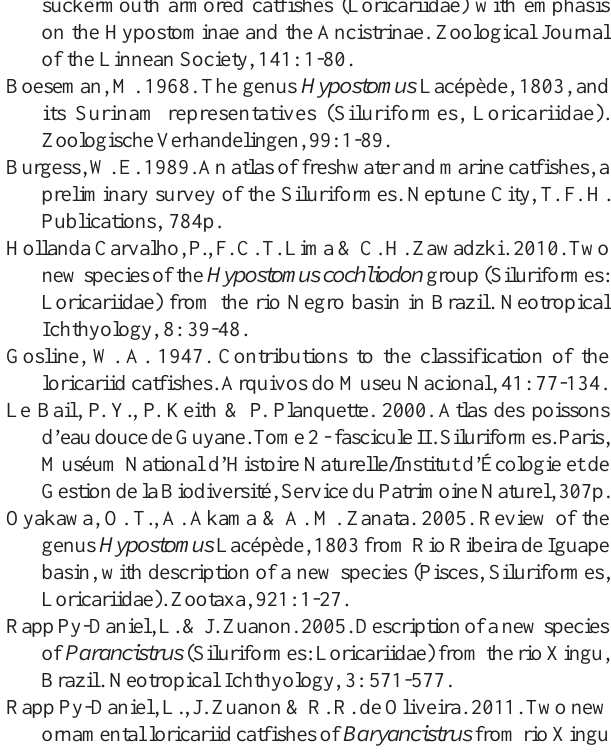
denticulatus : Goiás State: MZUSP 98770, holotype, 161.9 mm SL, rio do Peixe, rio Paranaíba basin, Caldas Novas. NUP 4306, 2, 144.3-158.5 mm SL, rio Corumbá, upper rio Paraná basin, Pires do Rio . Hypostomus johnii : Piauí State, Teresina: MCZ 7831, syntypes, 1, 94,0 mm SL, rio Poti, rio Parnaíba basin. MCZ 7864, syntypes, 2, 93.1-95.5 mm SL, rio Poti, rio Parnaíba basin. Hypostomus latirostris : BMNH 1892.4.20.26-27, syntypes, 2, 137.2-159.3 mm SL, rio Jangada, rio Paraguay basin. Mato Grosso State: NUP 11014, 4, 113.3-153.3 mm SL, rio Cuiabá, rio Paraguay basin, Cuiabá. NUP 12203, 1, 113 mm SL, rio Casca, rio Paraguay basin, Chapada dos Guimarães. Hypostomus meleagris : AMNH 12246, holotype, 252.8 mm SL, upper rio Paraná basin. Hypostomus multidens : São Paulo State: NUP 5340, paratype, 157.0 mm SL, rio Paranapanema, rio Paraná basin. NUP 5340, 1, 157.0 mm SL, Chavantes reservoir, rio Paranapanema, upper rio Paraná basin, Piraju. Paraná State: NUP 6776, 1, 167.0 mm SL, rio Paraná, upper rio Paraná basin, Doutor Oliveira Castro. Hypostomus mutucae : Mato Grosso State: MCP 28669, holotype, 67.7 mm SL; rio Mutuca, rio Paraguay basin, Chapada dos Guimarães. MZUSP 27694, 2, 75.0-79.4 mm SL, rio Mutuca, rio Paraguay basin, Chapada dos Guimarães. NUP